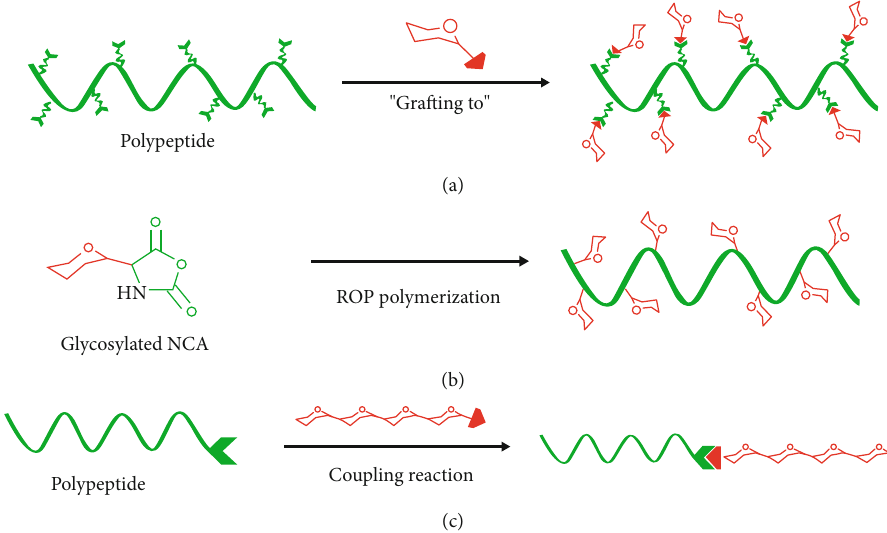
Figure 1: A general representation of synthetic strategies of glycopolypeptides by (a) postpolymerization glycosylation of synthetic polypeptides, (b) polymerization of glycosylated N-carboxyanhydrides (glycol-NCAs), and (c) glycosylation at the terminus group of a polypeptide.